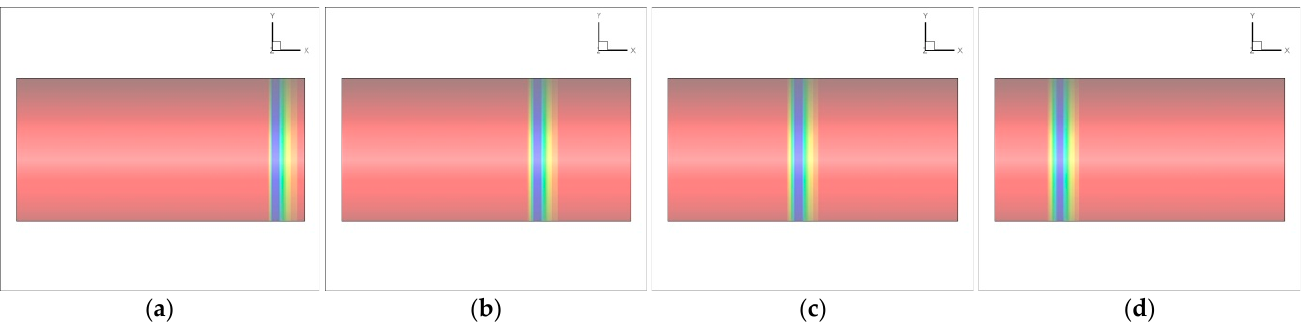
Figure 6. The outlet-pressure boundary condition. After the simulation with pressure pulse is accomplished, the propagation process can be obtained as shown in Figure 7.